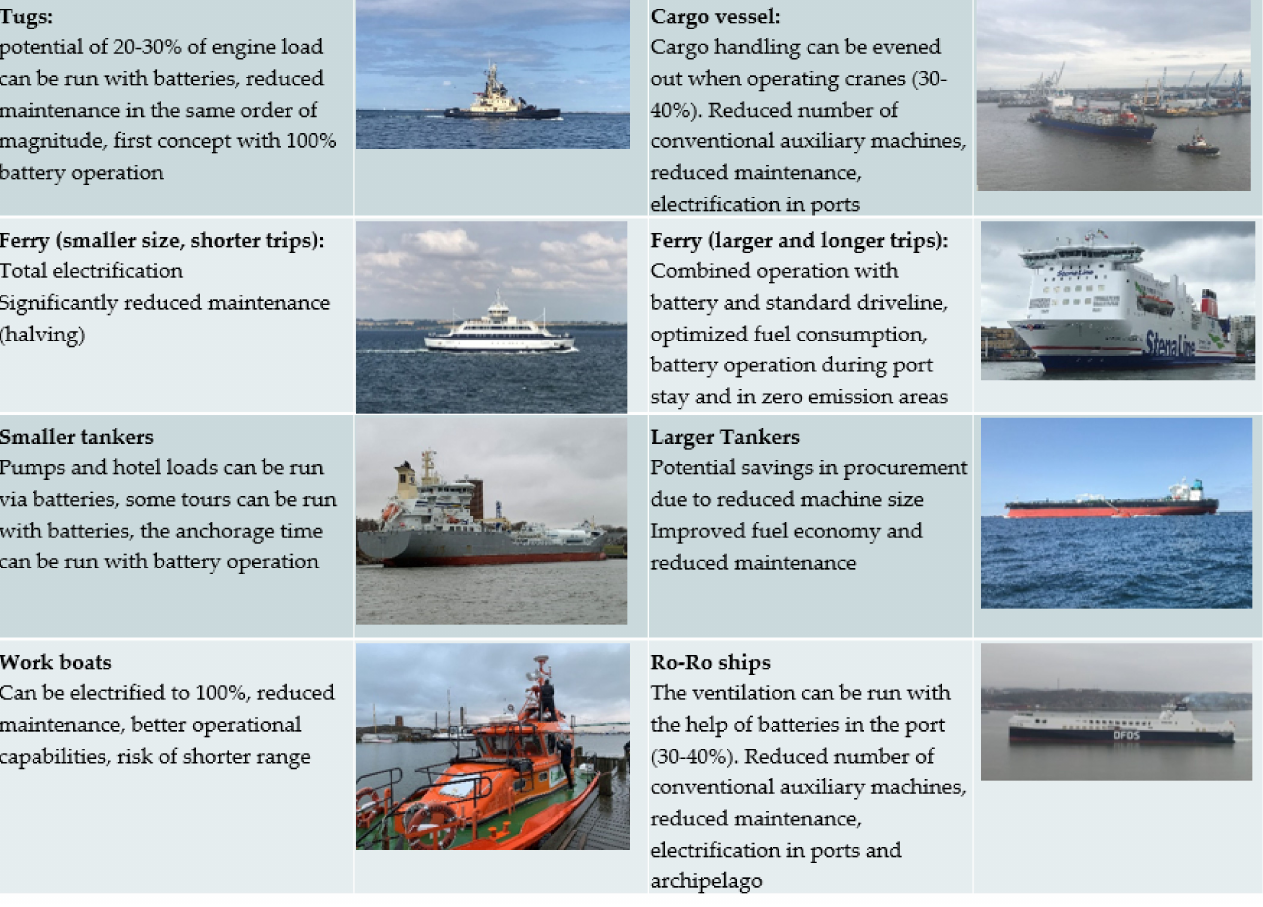
Figure 6. Potential of energy storage/battery usage in different